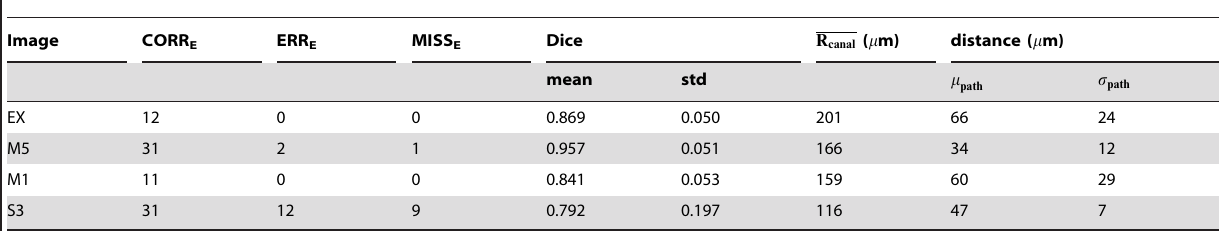
Table 3. Results of the pathway extraction.